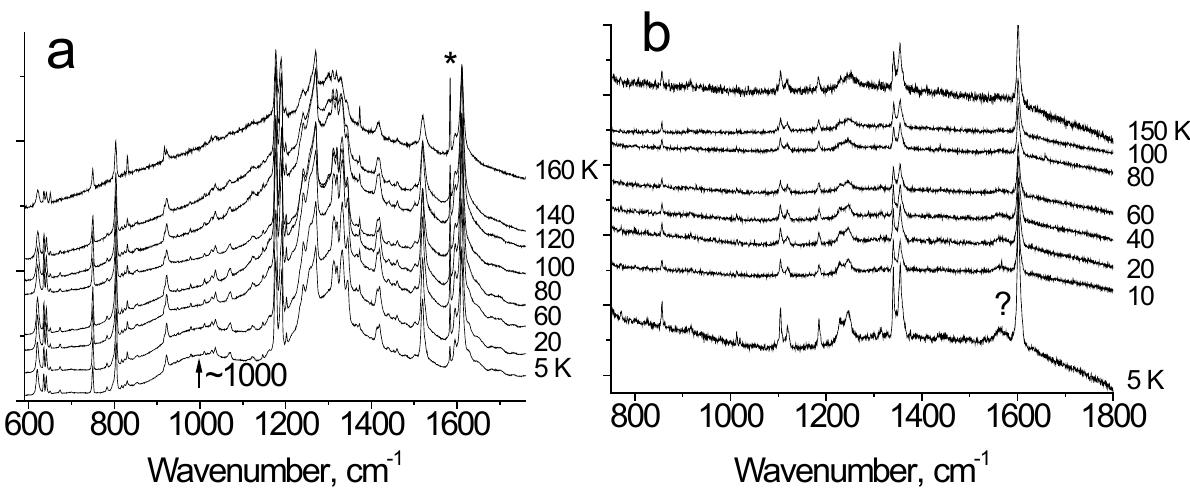
Figure 3. ( a , b ) Raman spectra of DBM − OMe ( a ) and DBM − NO 2 ( b ) at different temperatures. The spectra of both compounds contain a broad luminescent background. The asterisk (*) marks the positions of the line of the Ne lamp, which was registered at each temperature for the wavenumber correction of the spectra. The sign (?) refers to a weak line, the origin of which is unclear.